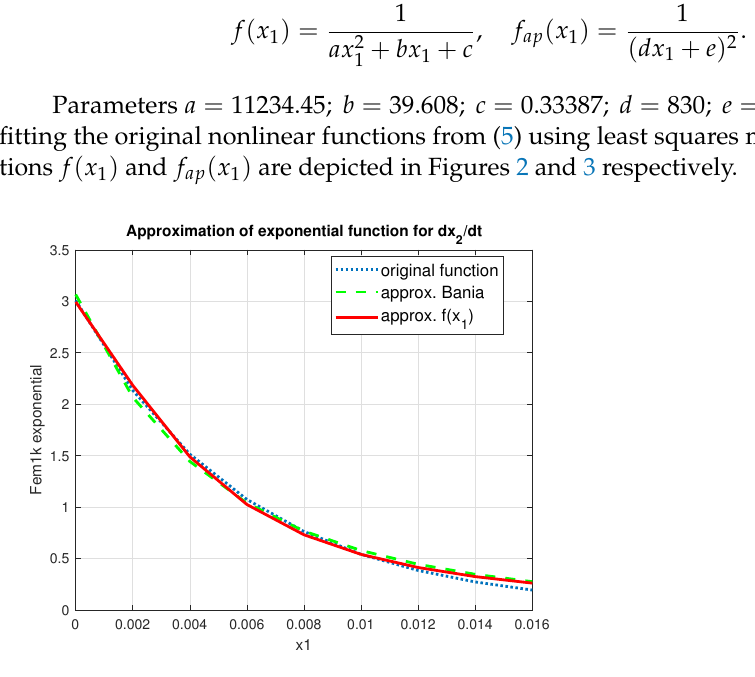
Figure 2. Quadratic rational function approximation of exponential term for dx 2 simpler rational function from [22]—in green.